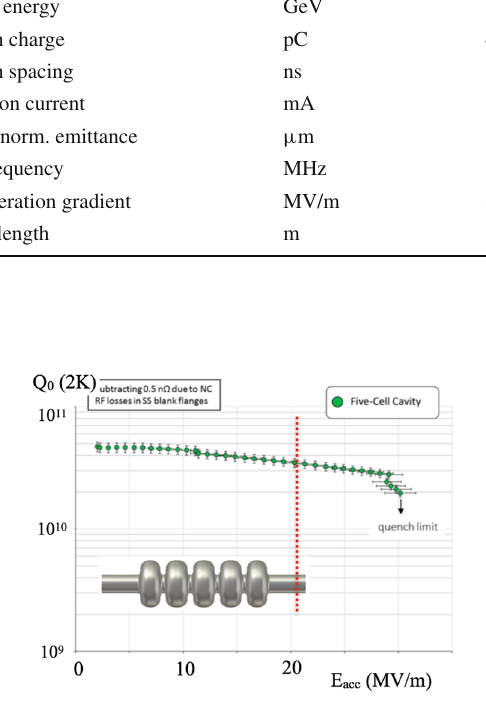
Fig. 10 Q-parameter of the 5 cell cavity